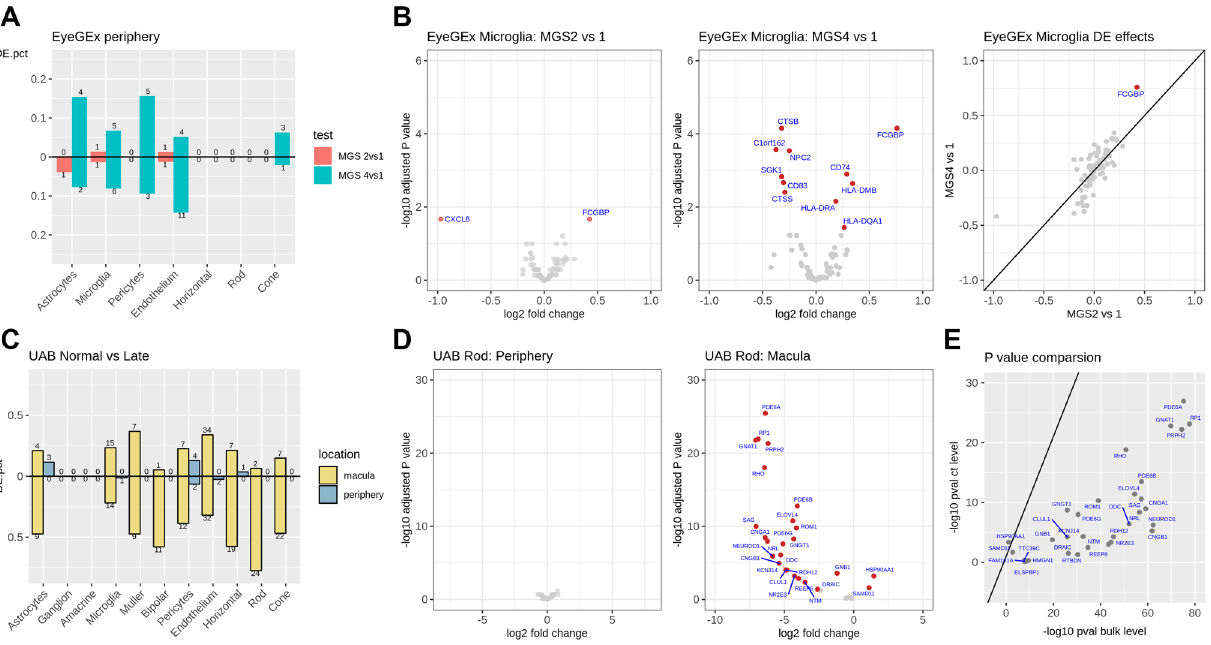
Figure 5. Cell type-specific differential expression analysis in two datasets. ( A ) Proportions (y-axis) of up- and down-regulated ctDEGs detected in the EyeGEx peripheral retina data. Colors show different test conditions: red for MGS2 vs. MGS1, and green for MGS4 vs. MGS1. Numbers above each bar indicate the number of detected ctDEGs for each comparison. ( B ) Volcano plots and effect size comparison of microglia-specific DEGs detected in the EyeGEx peripheral retina data. Significant ctDEGs were colored in red and annotated with gene names. ( C ) Proportions (y-axis) of up- and down-regulated ctDEGs for control vs. advanced AMD comparison in the UAB bulk RNA-seq data. Colors show different retina regions: blue for periphery, and yellow for macula. Numbers above each bar indicate the number of detected ctDEGs for each comparison. ( D ) Volcano plots and effect size comparison of rod-specific DEGs identified for control vs. advanced AMD comparison in the UAB bulk RNA-seq data. Significant ctDEGs were colored in red and annotated with gene names. ( E ) Comparison of p-values for cell type level and bulk level differential expression analysis for control vs. advanced AMD comparison in the UAB bulk RNA-seq data in macula rod